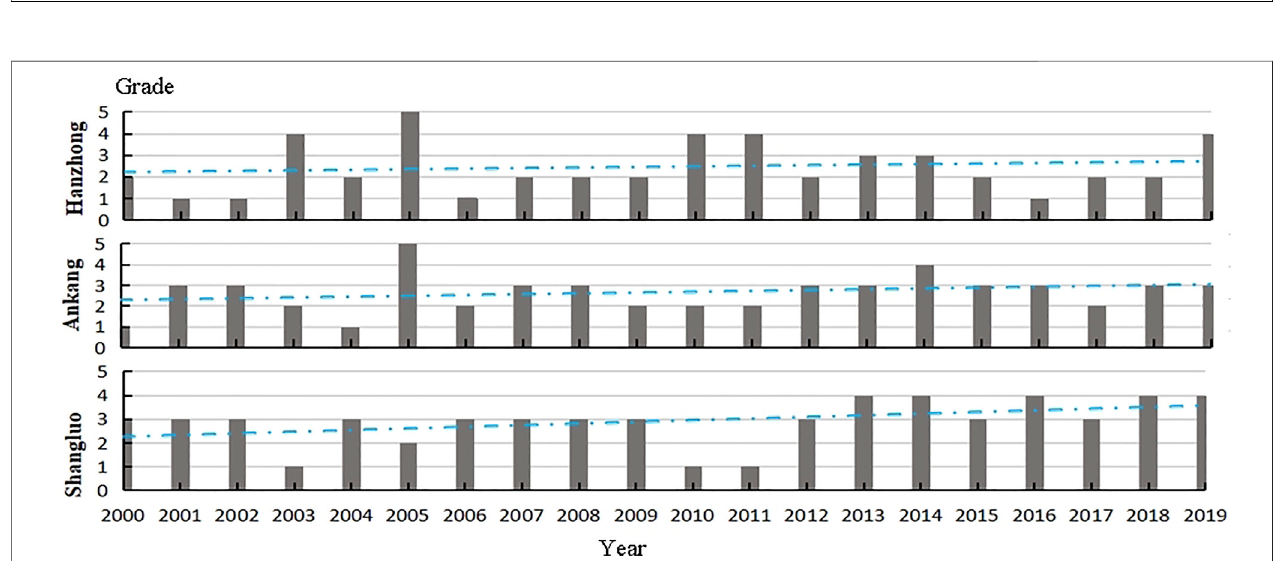
FIGURE 5 | Evaluation results of water resources value in Shiyan city, Hubei province.